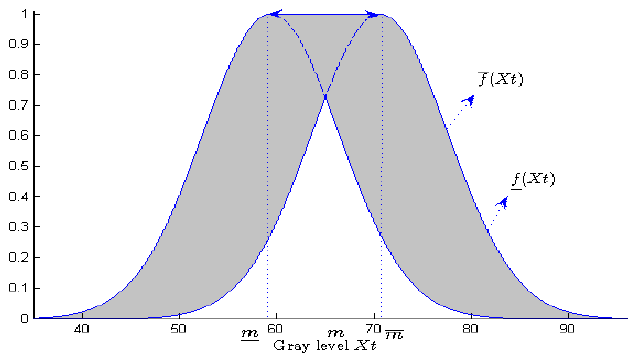
Figure 4. Gaussian interval type-2 fuzzy set (uncertain